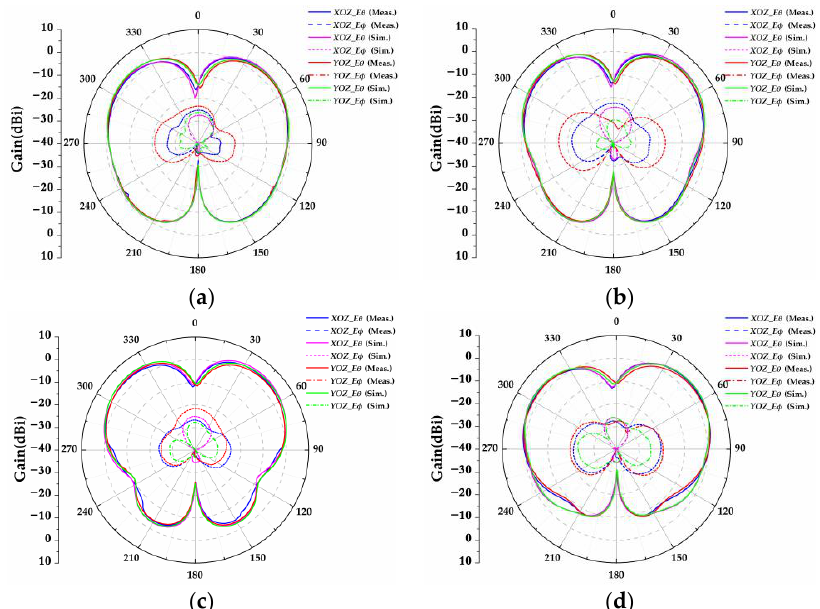
Figure 13. Simulated and measured radiation patterns of State-II: ( a ) 1.6 GHz; ( b ) 1.8 GHz; ( c ) 2.0 G Hz; ( d ) 2.3 GHz.